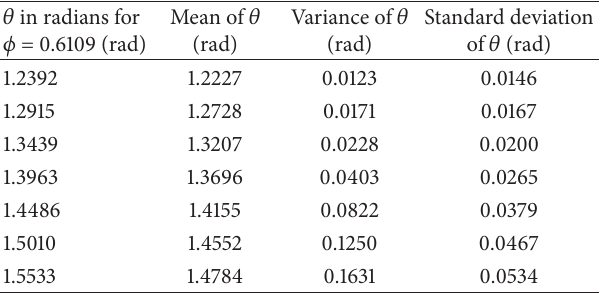
Table 10: Means, variances, and standard deviations at 10dB noise for different elevation angles and fixed azimuth angle by using PM with parallel-shape array [8].